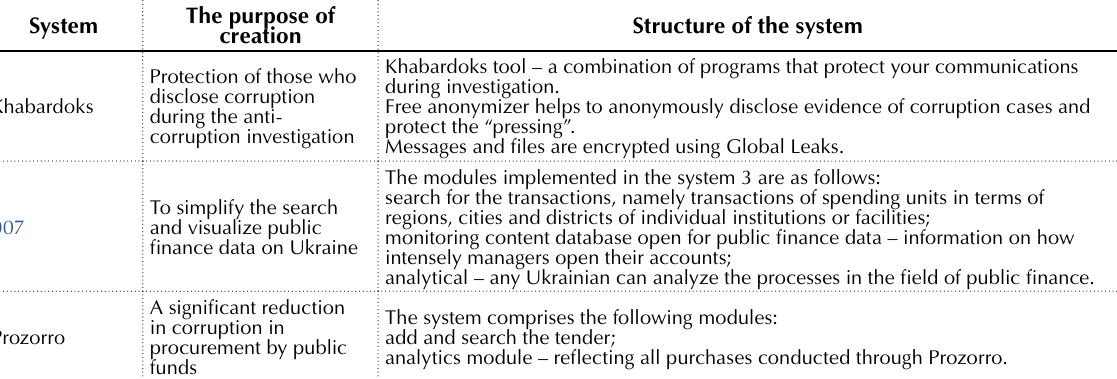
Table 2. Anti-corruption platforms of